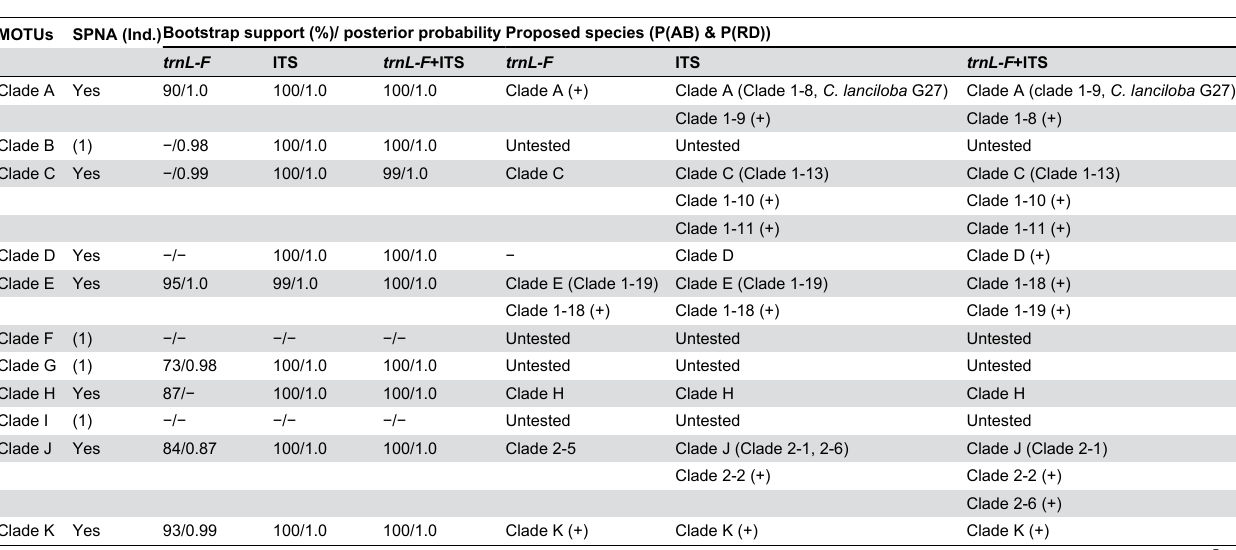
Table 2. Summary of the accumulated evidence supporting molecular operational taxonomical units (MOTUs) A to